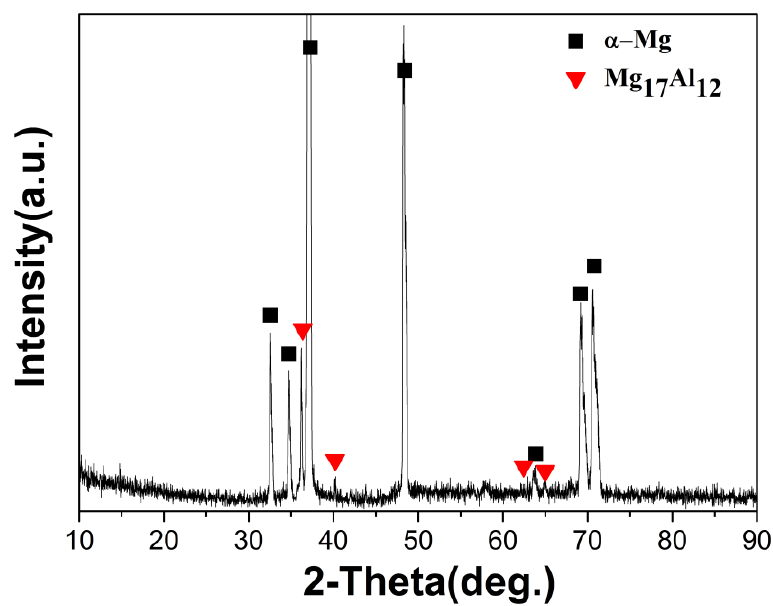
Figure 2. X-ray di ff raction (XRD) pattern of the as-cast AZ80 alloy. Figure 2. X-ray diffraction (XRD) pattern of the as-cast AZ80 alloy. Figure 2. X-ray diffraction (XRD) pattern of the as-cast AZ80 alloy.